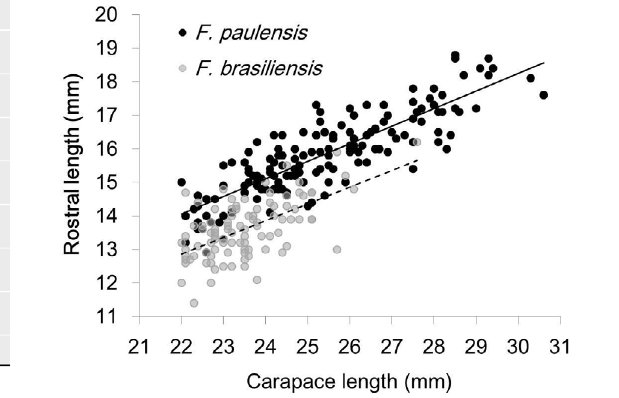
Figure 6. Relationship between rostral length (mm) and carapace length (mm) of Farfantepenaeus paulensis and F. brasiliensis specimens caught in April 2019 in the Rocha